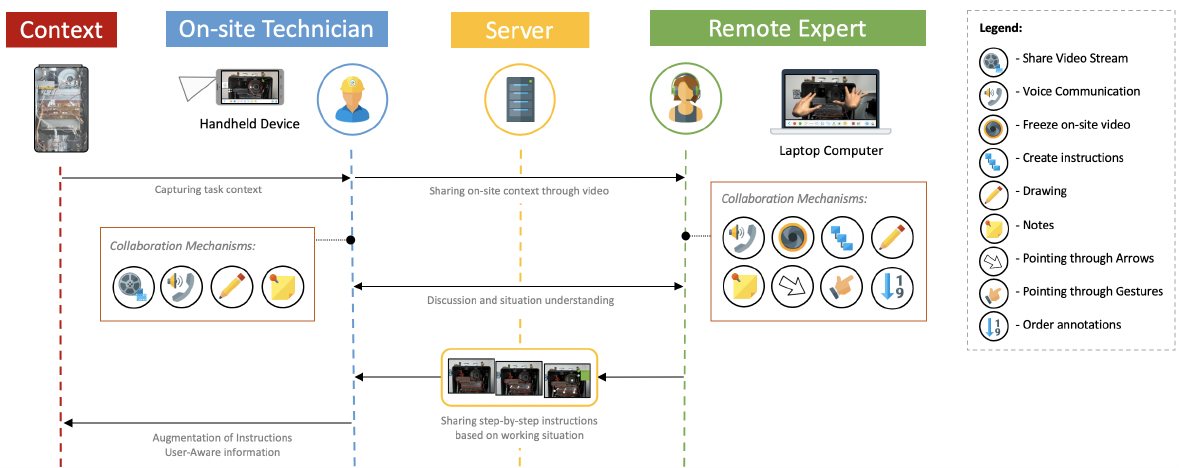
Figure 2. Information flow overview. Goal: Allow an on-site technician to share the context of the task (through video stream) for discussion and situation understanding with a remote expert. The expert can freeze the on-site worker video stream and create AR-based instructions using mechanisms to annotate it. Finally, the technician can view the real world augmented with the instructions and perform an